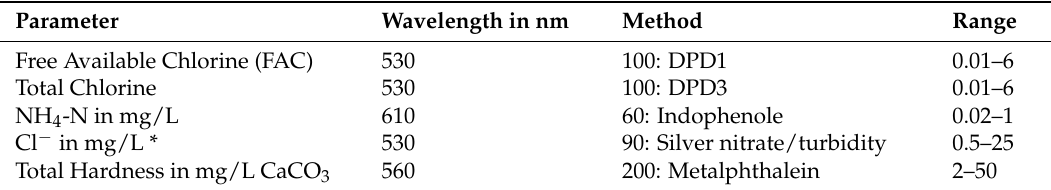
Table 2. Parameters and methods used for analysis with the AL410